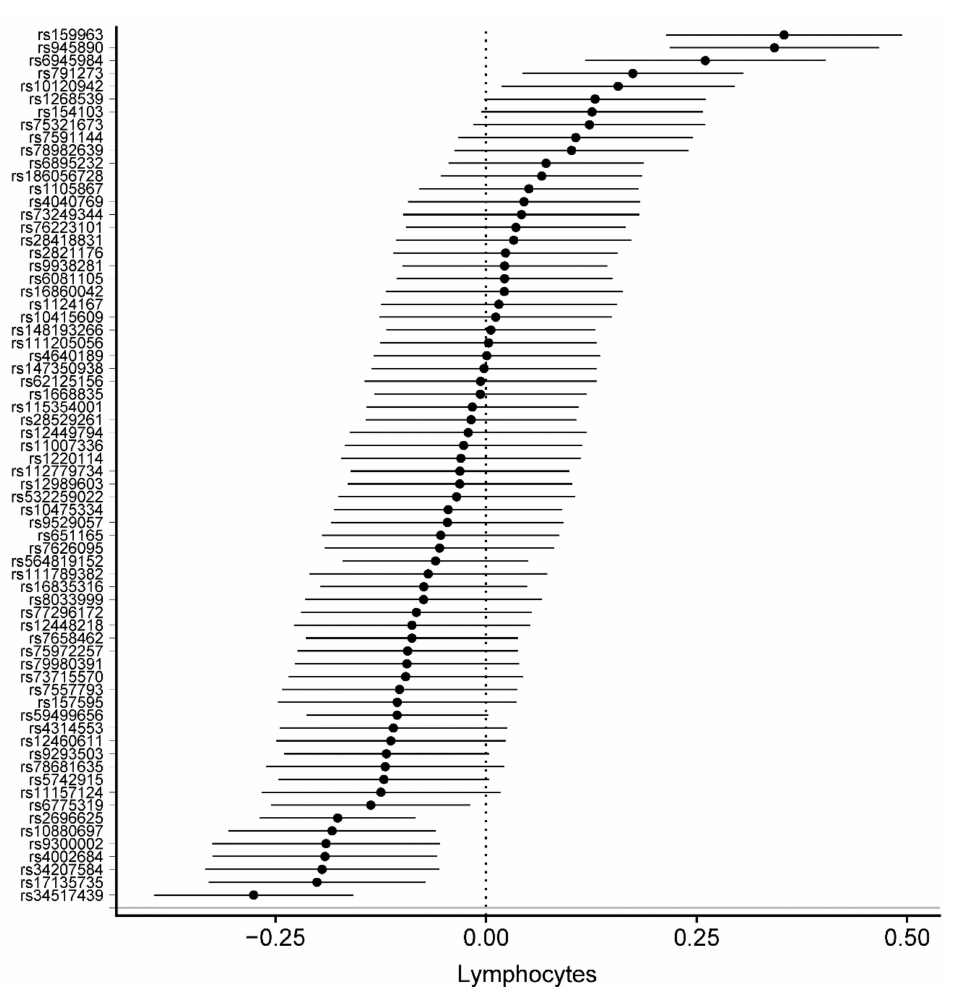
Figure 2. Forest plot of physical activity single nucleotide polymorphisms on lymphocyte